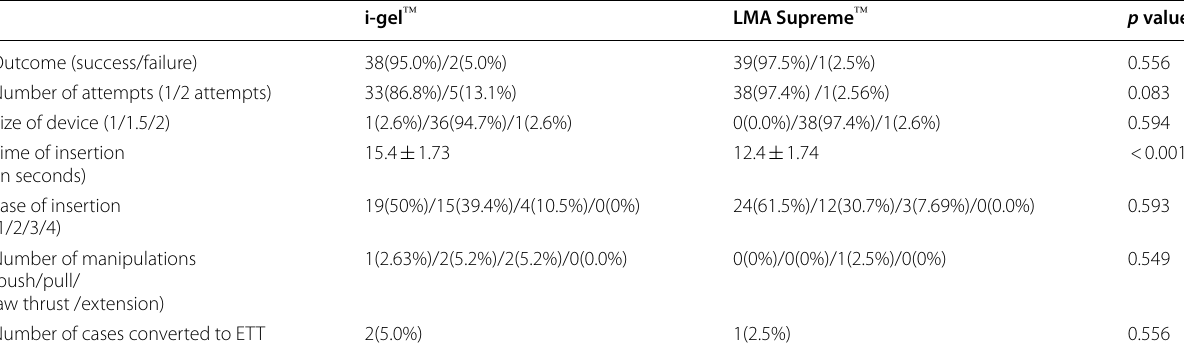
Values are expressed as mean